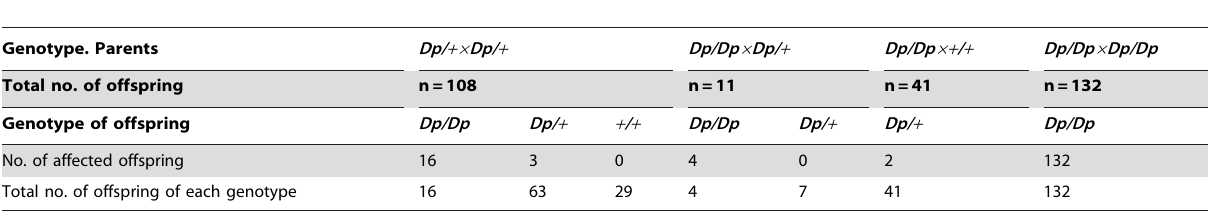
Table 1. Genetic model testing.